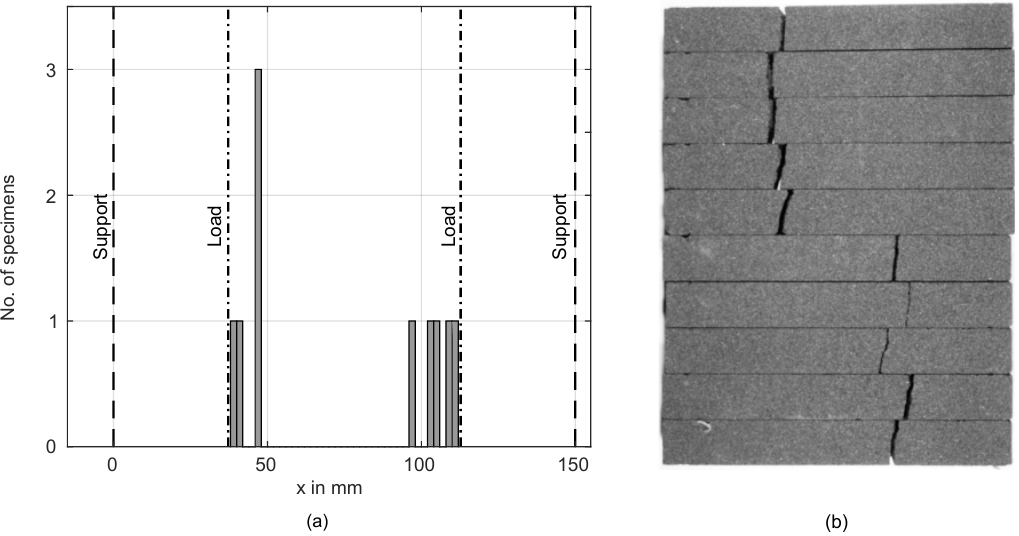
Figure 12. Fracture locations for a 4PB experiment with a 75.5-mm load distance ( a ) and the broken bending beams ( b